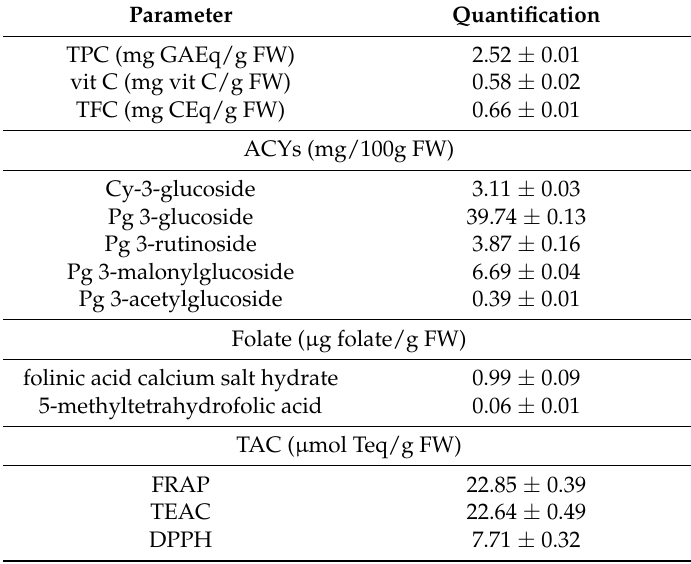
Table 1. Phytochemical and antioxidant capacity of Alba strawberry extract. Data are presented as mean value ± SD.